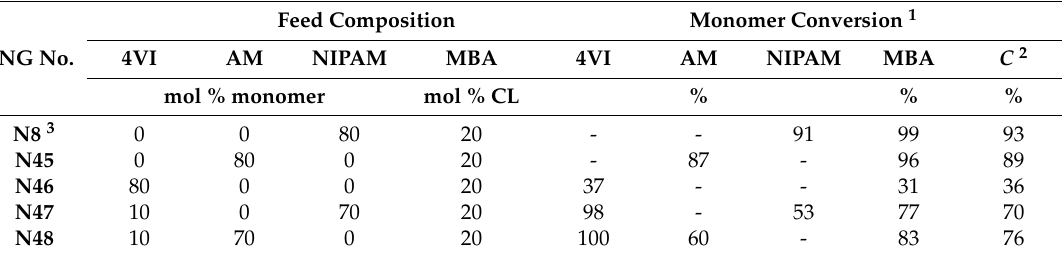
Table 2. Monomer conversions measured for nanogels N8 and N45 – N48